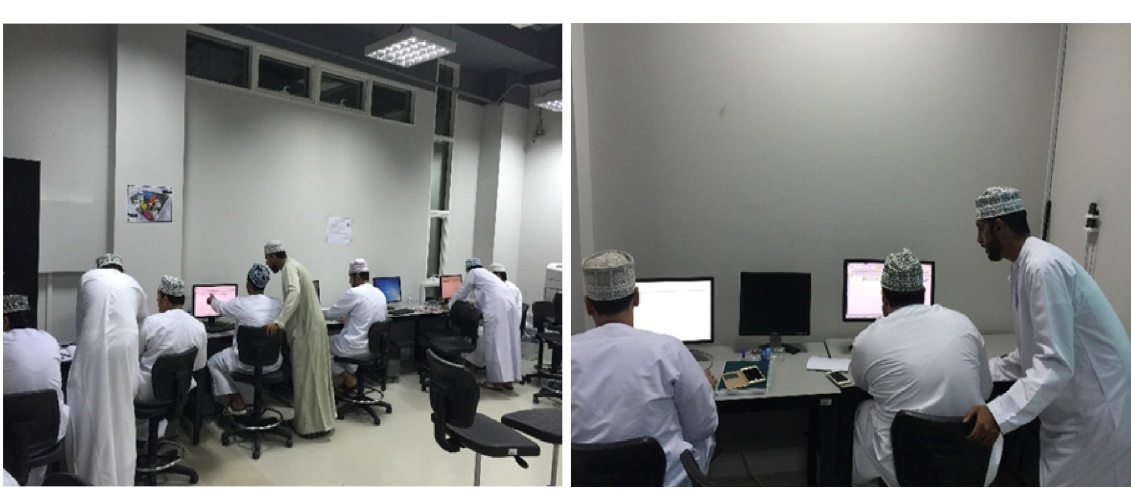
Figure 2. Peer teaching activity in laboratory